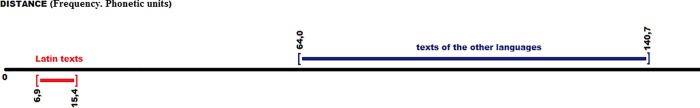
Distances between the Latin (average value) with all the texts of all the languages (phonetic units).